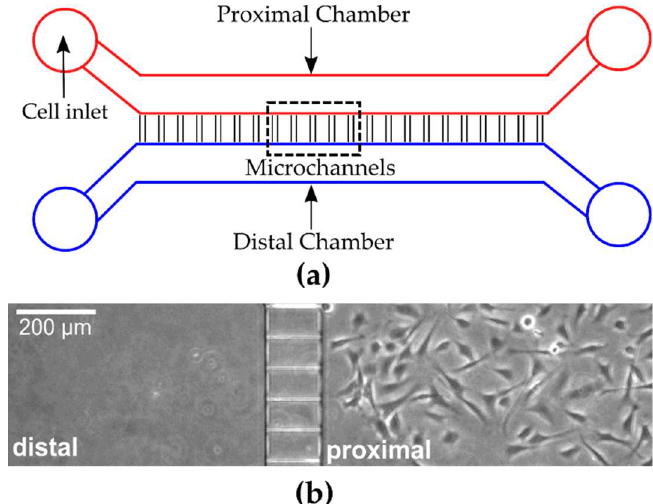
Figure 1. Schematic illustration of microfluidic device. ( a ) Representative drawing of PDMS based microfluidic device with distinct proximal and distal chambers. The red region indicates the proximal chamber in which the cells are seeded and is connected to a distal chamber (blue region) by an array of microchannels. ( b ) Phase contrast image of a section of the proximal and distal chamber after myoblast seeding in the proximal chamber.